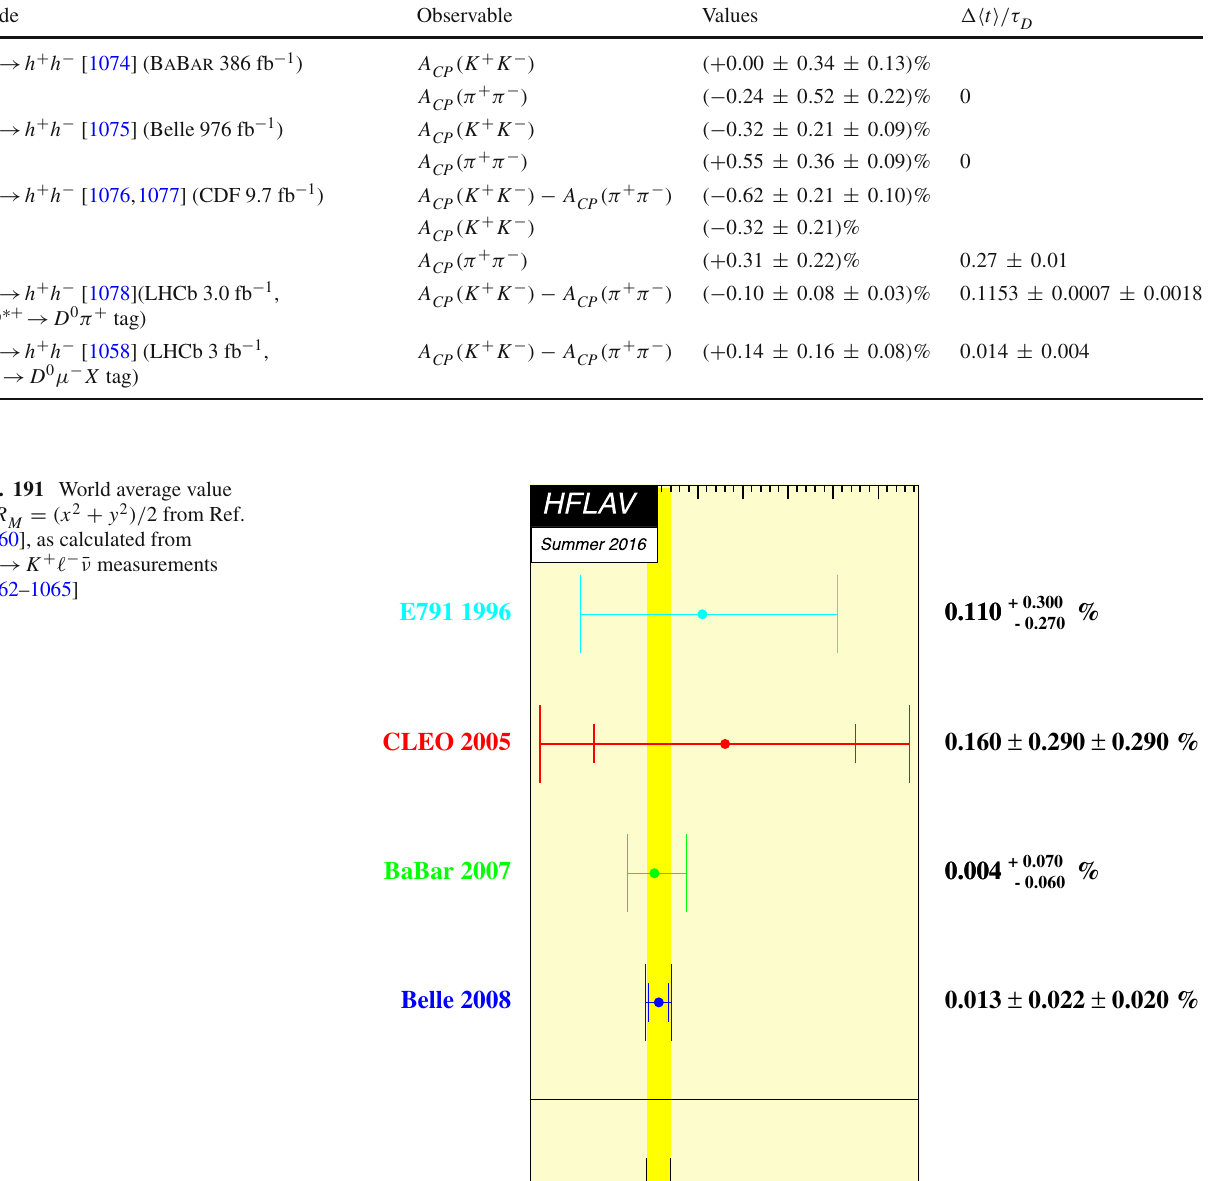
Table 261 Measurements of time-integrated CP asymmetries. The ( f ) ≡ [ (cid:6)( D 0 → f ) − (cid:6)( ¯ D 0 → f ) ] / [ (cid:6)( D 0 → observable A CP